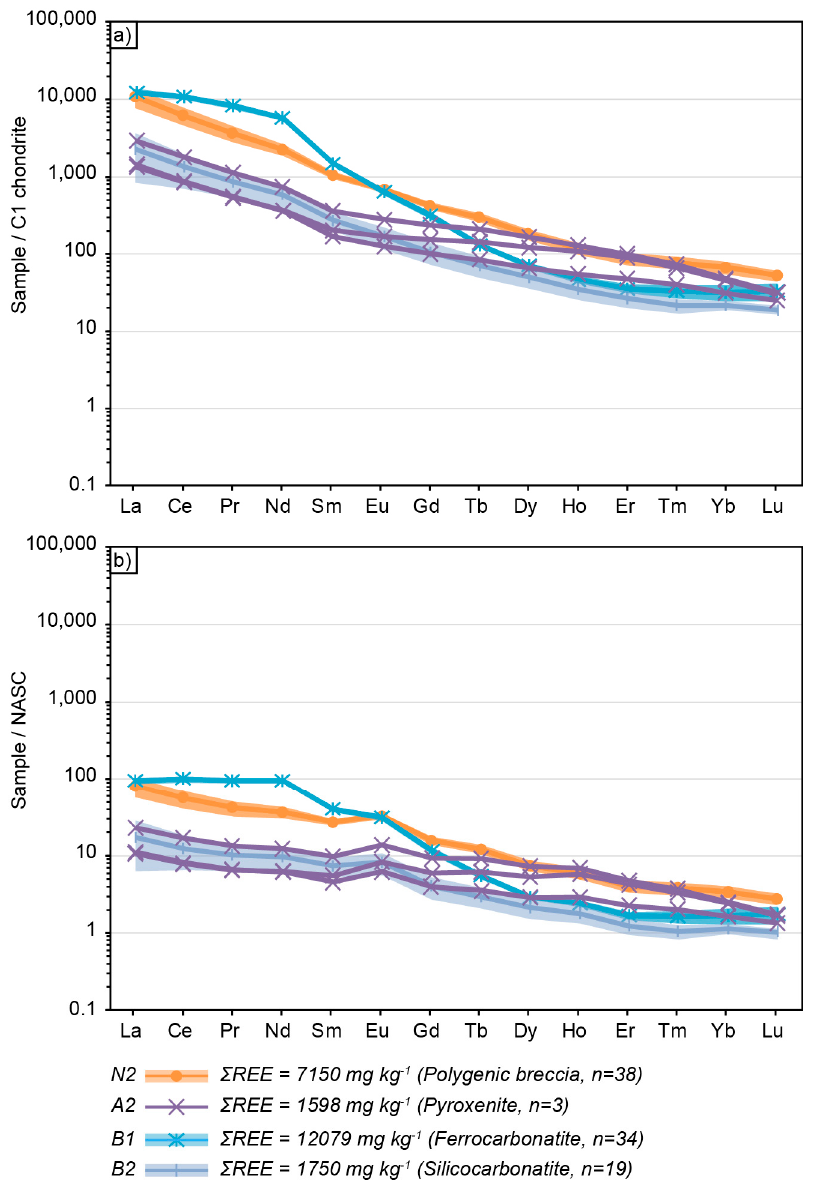
Figure 2. ( a) Chondrite-normalized (Reference [25]) and ( b ) North American shale composite (NASC)-normalized (Reference [26]) rare earth element (REE) patterns of the four parent materials (PMs) from the Montviel area investigated in this study. Lines correspond to mean values, and shaded areas correspond to 95% confidence intervals for N2, B1, and B2. All data of A2 are represented according to the limited number of replicates ( n = 3).